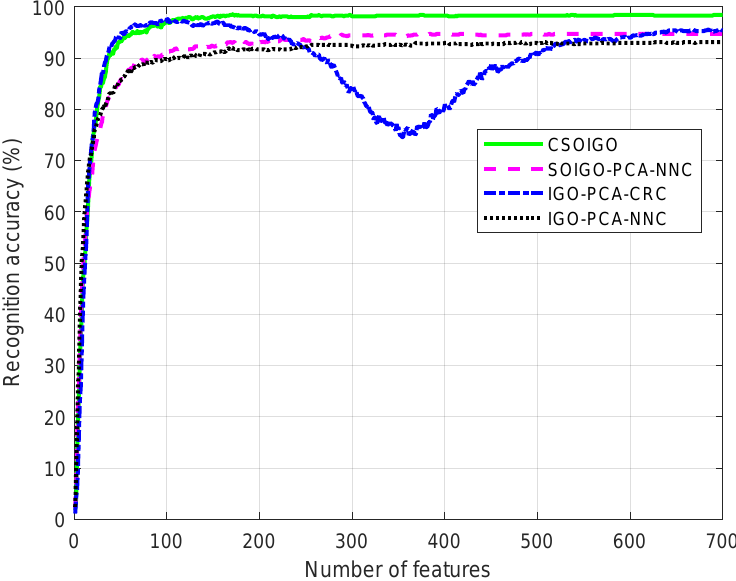
Figure 8. Recognition accuracy versus different number of features under mixed